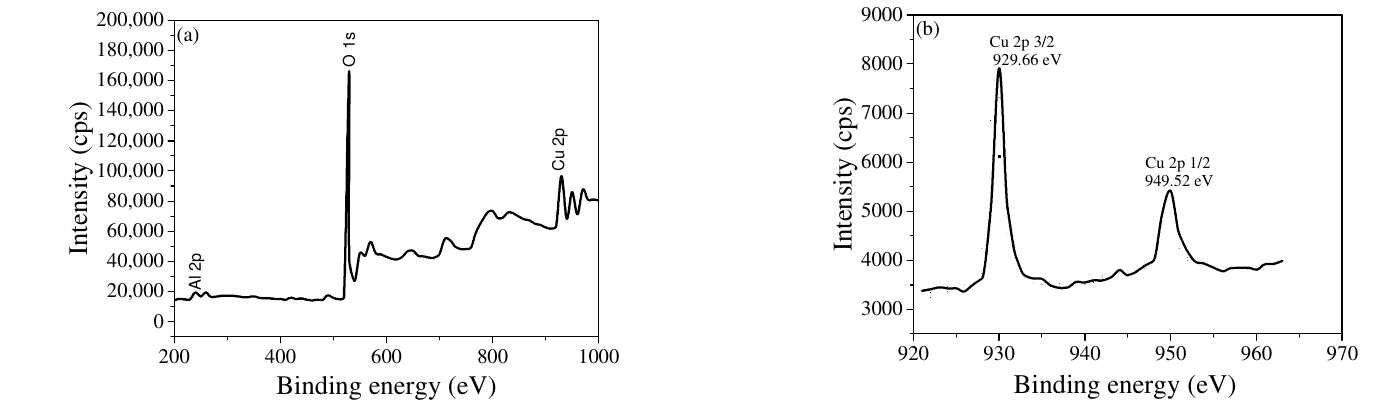
Figure 4. The ( a ) full range and ( b ) narrow range XPS spectrum of the Cu 2 O/Al 2 O 3 coating.